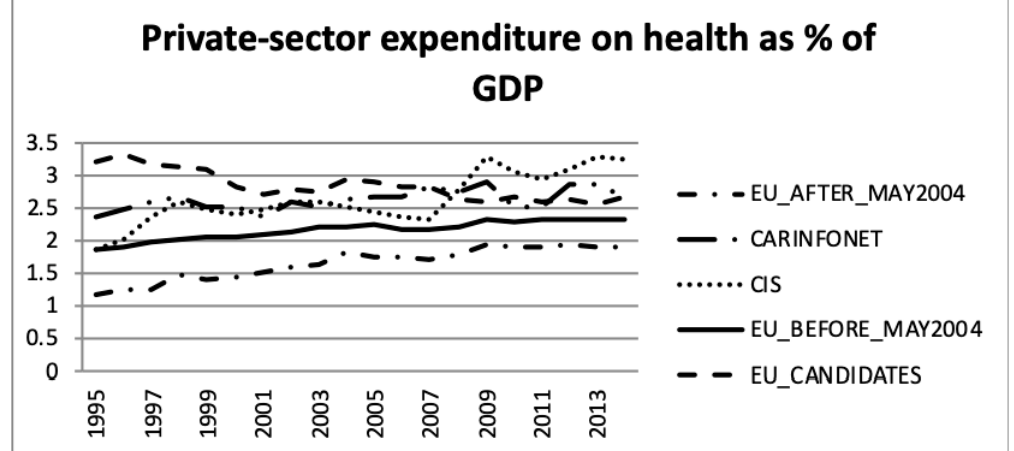
Figure 4. Public and private sector expenditure on health as a percentage of Gross Domestic Product (GDP), the World Health Organization estimates.